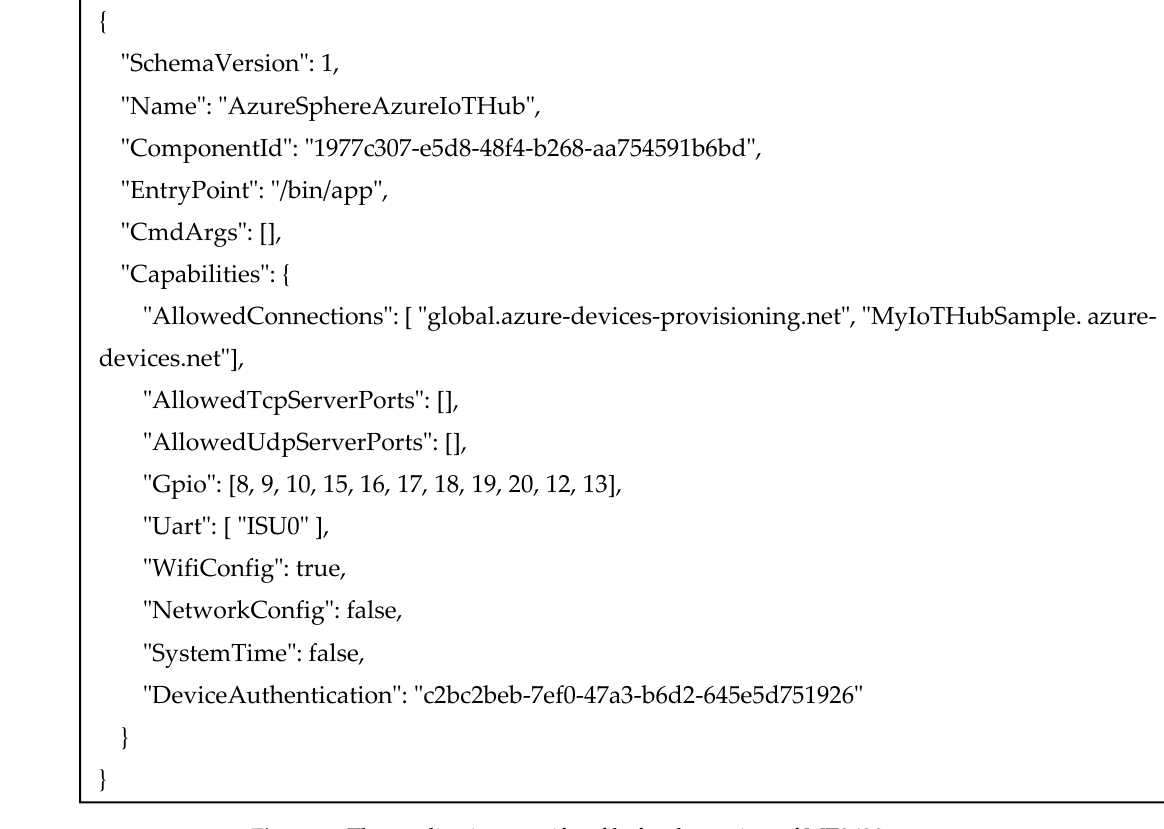
Figure 5. The application manifest file for the project of MT3620 as gateway.